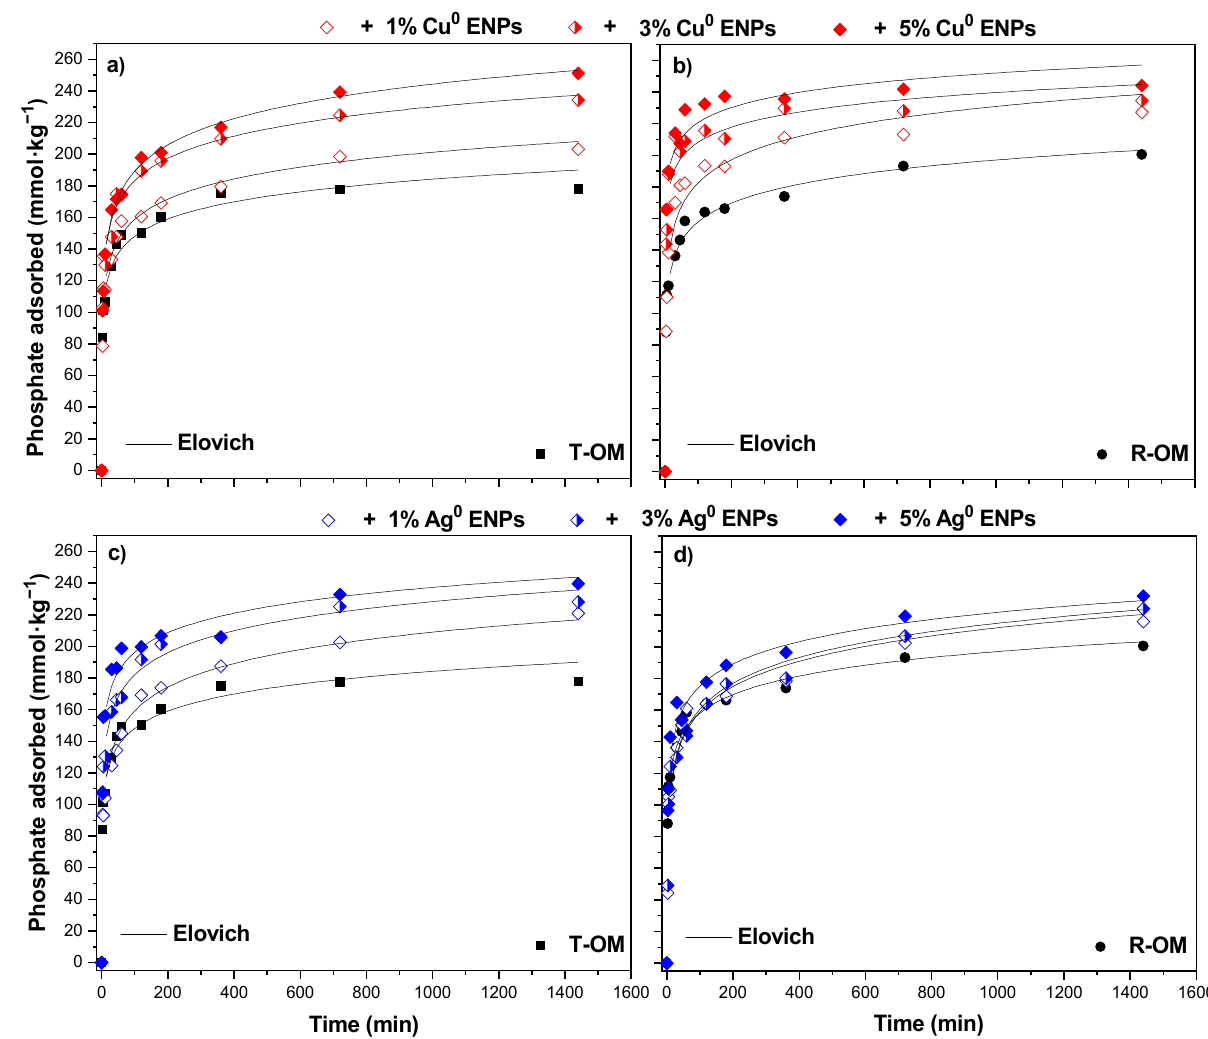
Figure 3. Phosphate adsorption kinetics at pH 5.5 ± 0.2 of the solution in the presence of Cu 0 ENPs on soil with ( a ) total organic matter (T-OM) and ( b ) partial removal of organic matter (R-OM) and Ag 0 ENPs on soil with ( c ) T-OM and ( d ) R-OM modelled by the Elovich model.